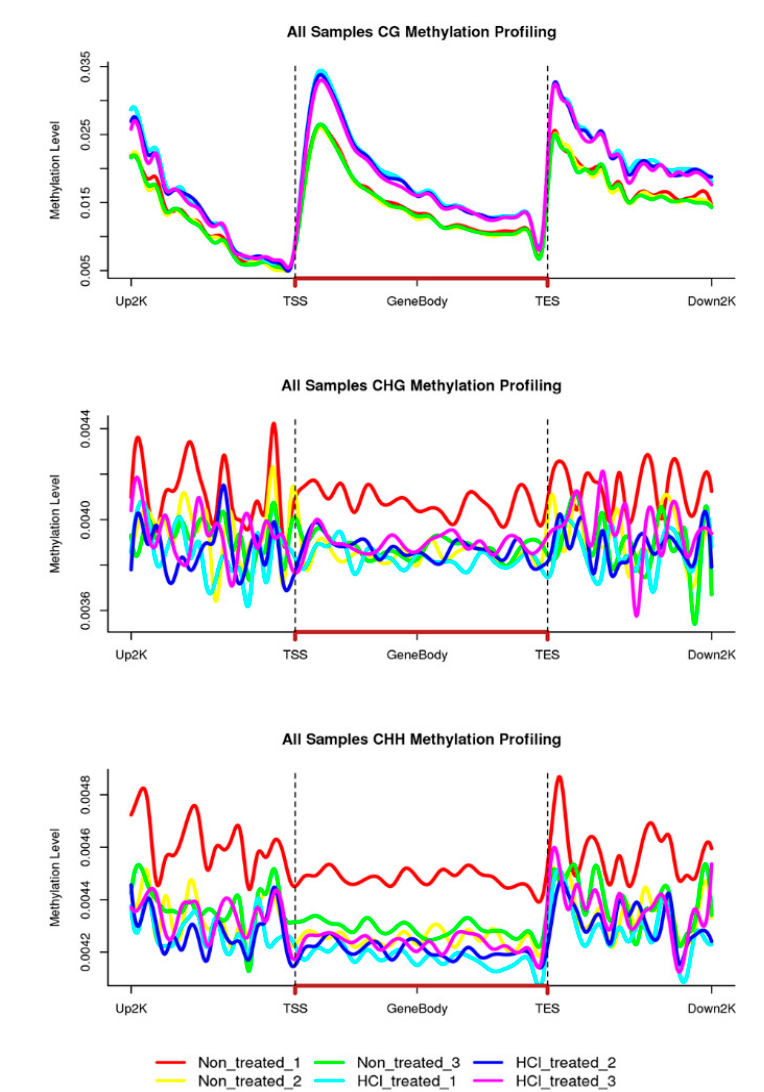
Figure 6. Percentage methylation levels in gene bodies and 2 kb upstream and downstream regions. Different coloured lines represent different experimental repetitions.